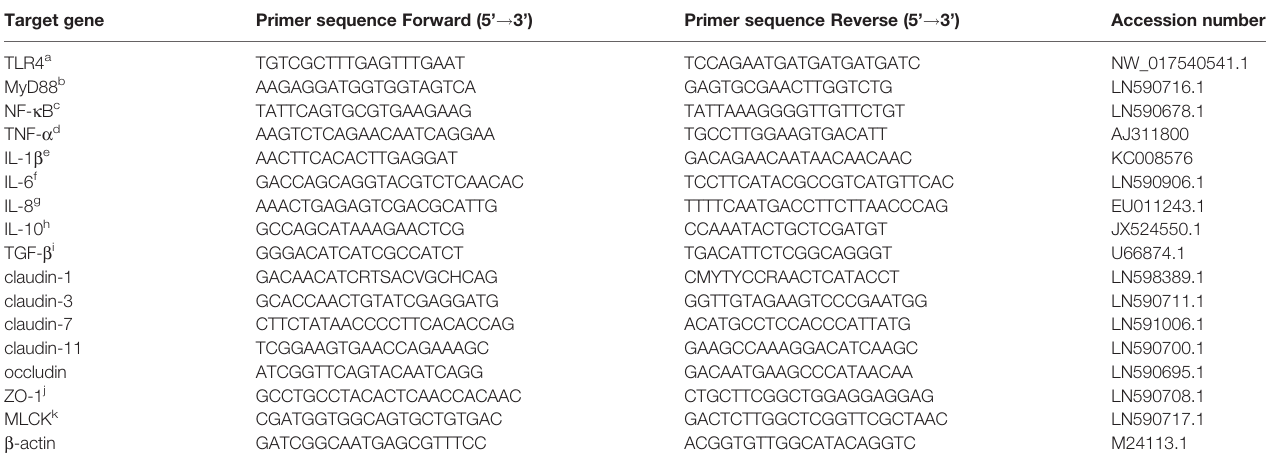
TABLE 2 | Real-time PCR primer sequences.